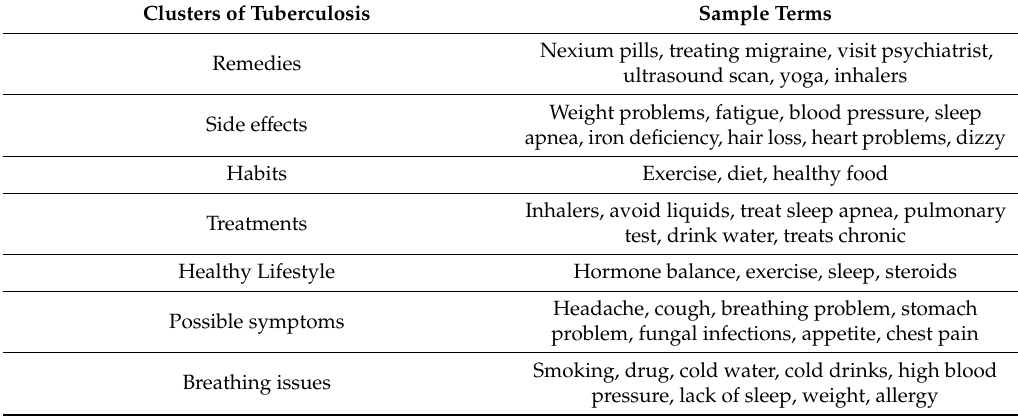
Table 3. Sample keywords extracted from each cluster of tuberculosis